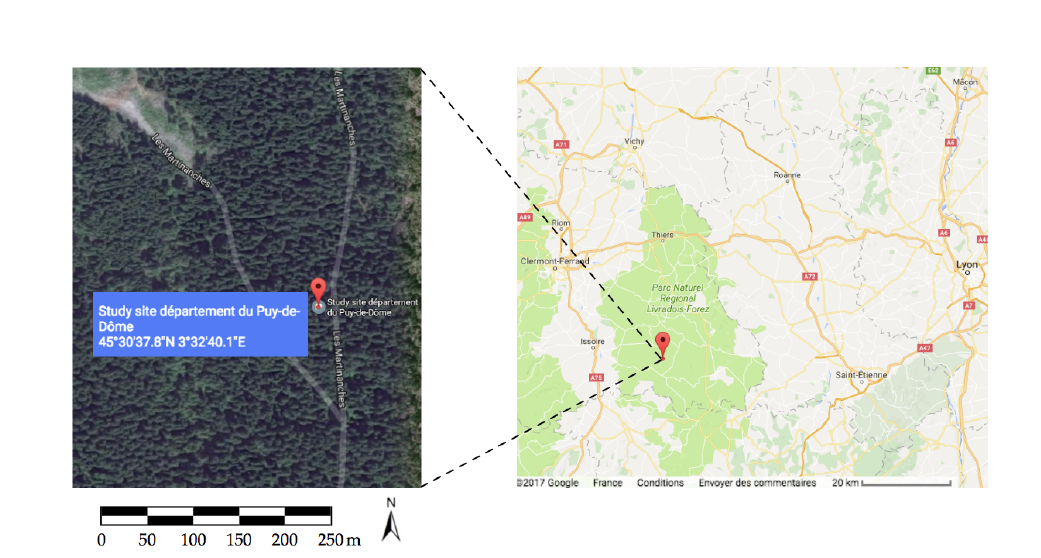
Figure 5. Study site in the Auvergne-Rhone-Alpes region (département du Puy-de-Dôme) of Central France. Source: Google Maps, 19 August